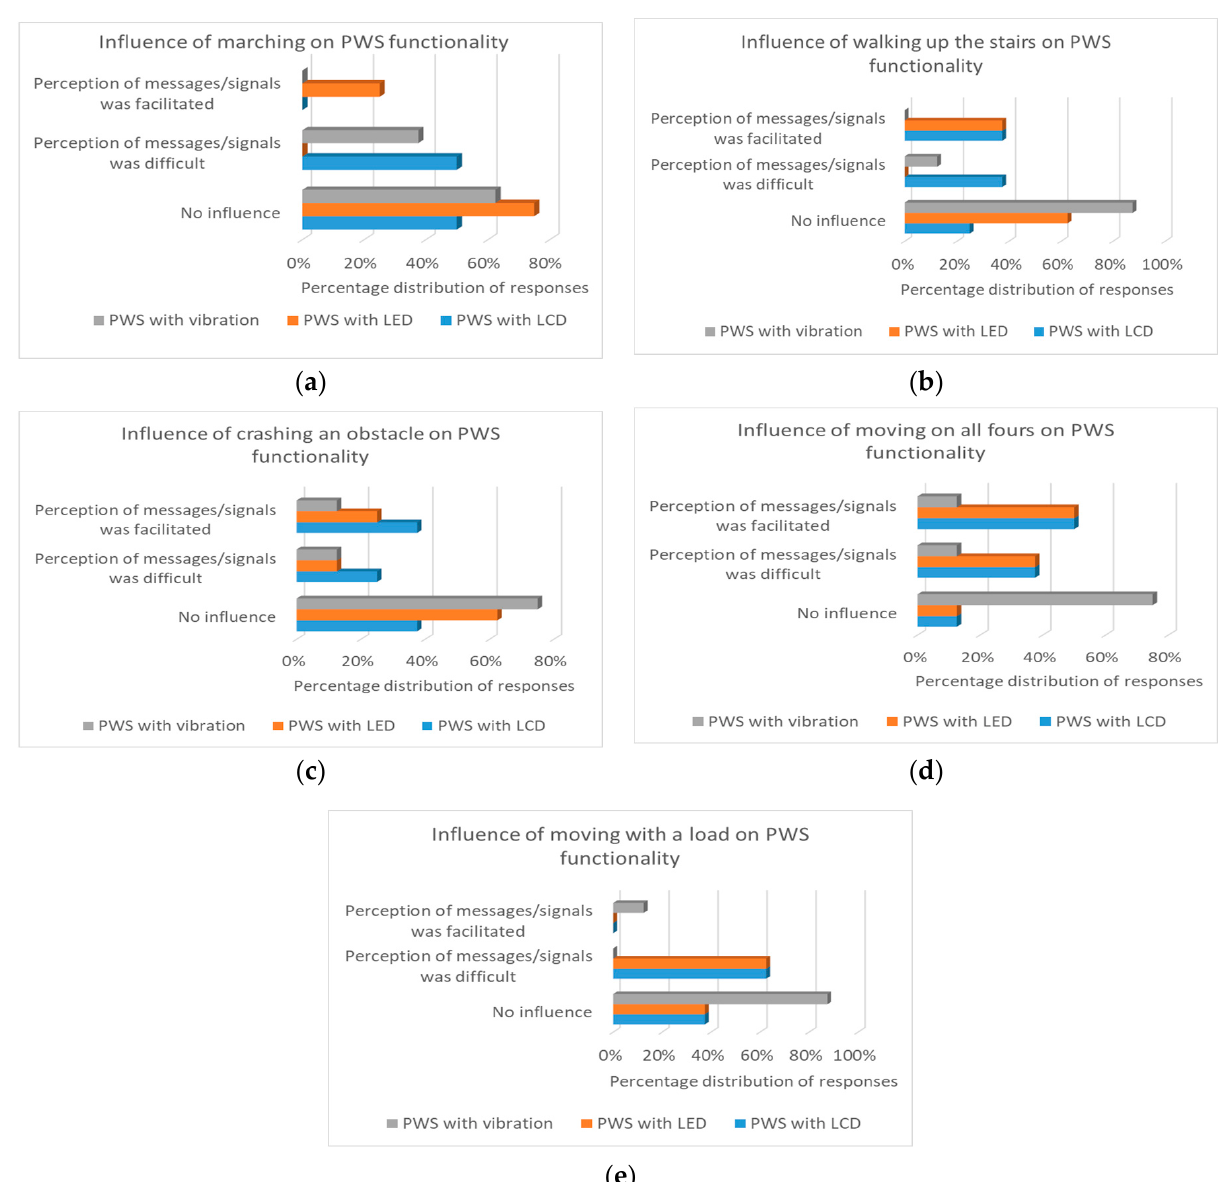
Figure 3. Survey results of the influence of the type of physical activity on the functionality of the PWS: ( a ) treadmill; ( b ) climbing trainer; ( c ) upper lift; ( d ) moving on all fours; ( e ) moving with a load.